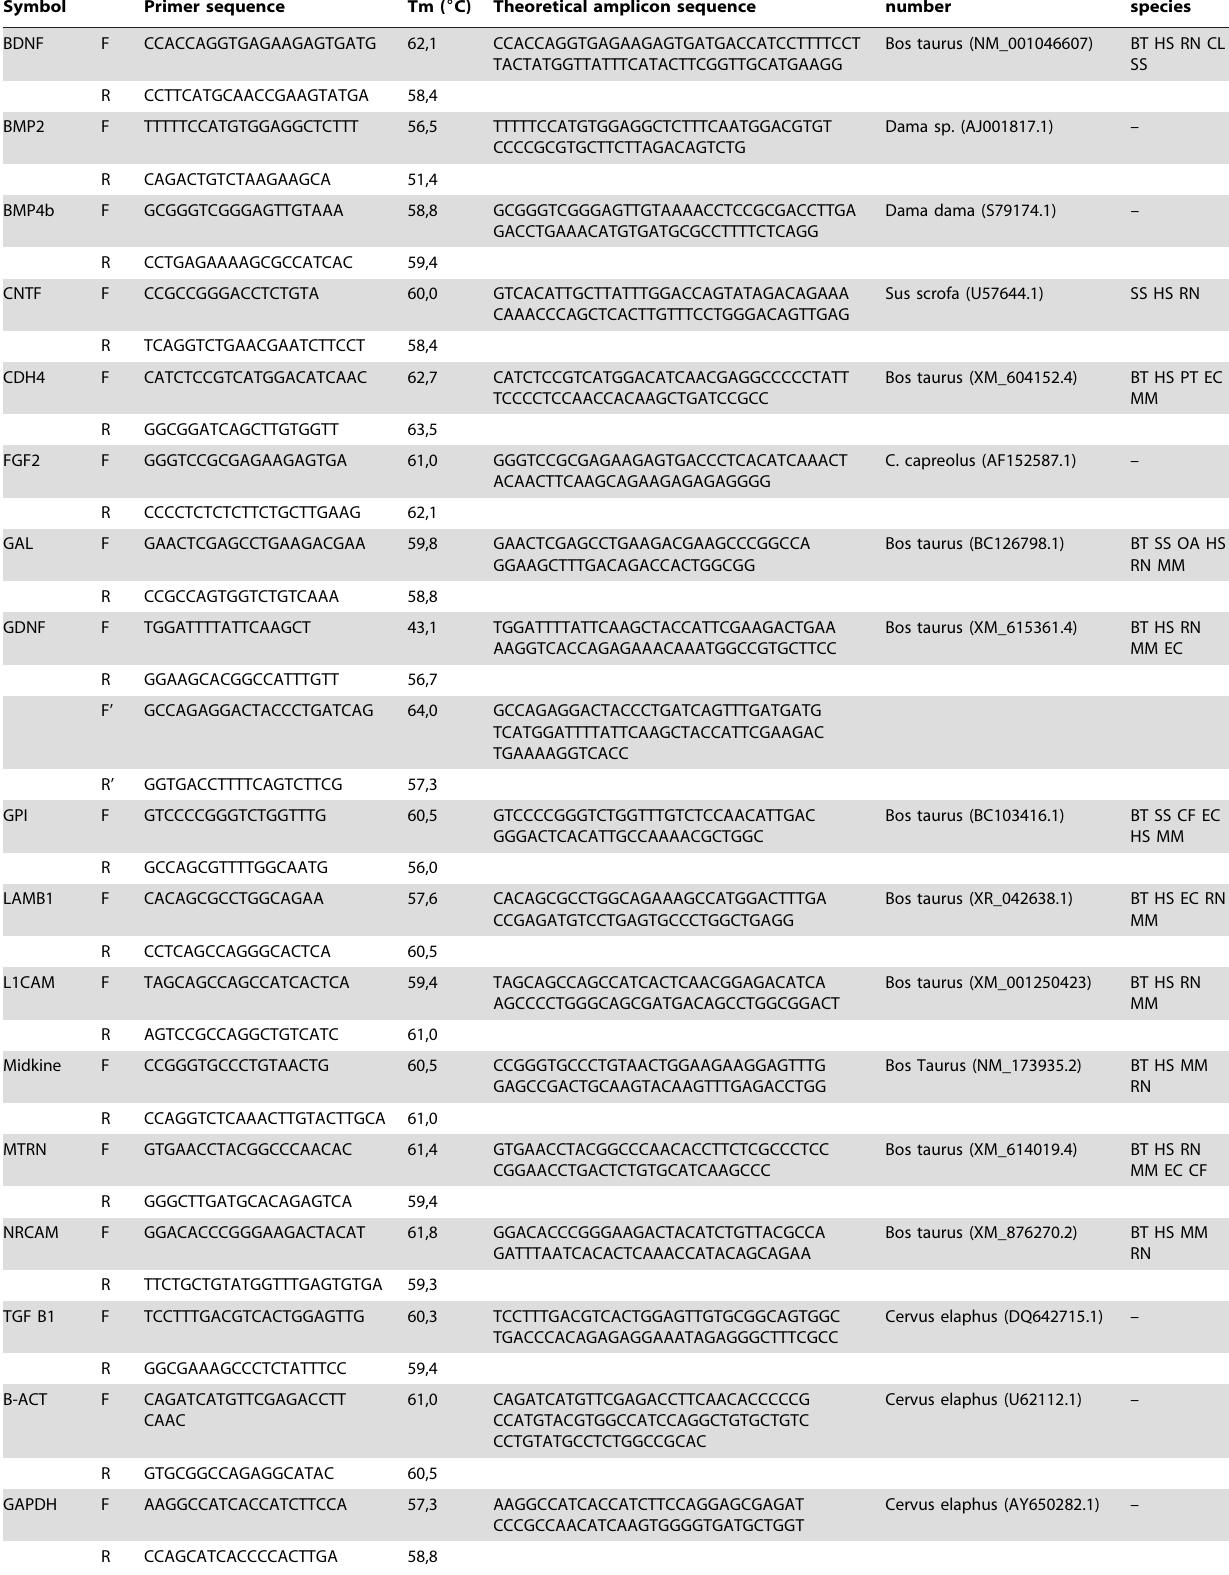
Primers employed for real time PCR. The table details the gene symbol, primer sequence (F corresponds to forward primer and R to reverse), melting temperature (Tm, in degrees celsius), the hypothetical amplicon sequence together with the species of origin and its genbank accession number. The last column (compared species) indicate the species used in the comparison to identify conserved regions within the target sequence. BT corresponds to Bos taurus , OA to Ovis aries , SS to Sus scrofa , EC to Equs caballus , HS to Homo sapiens , RN to Rattus norvegicus , MM to Mus musculus , CL to Canis lupus y CF to Canis familiaris